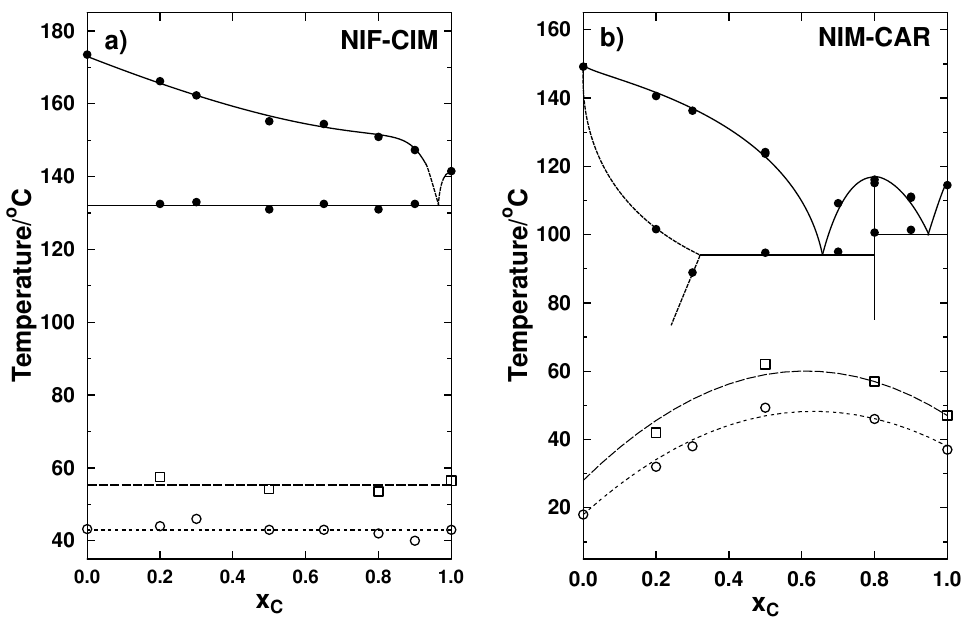
Figure 4. Phase transition diagrams for the binary systems. Liquidus and eutectic temperatures are shown with filled circles. In the phase diagrams are also included the glass transition temperatures measured immediately after the quenching (empty circles) and after storage (empty squares) for ( a ) NIF-CIM showing glass transition temperatures at 0 and 133 days of storage and ( b ) NIM-CAR at 0 and 85 days of